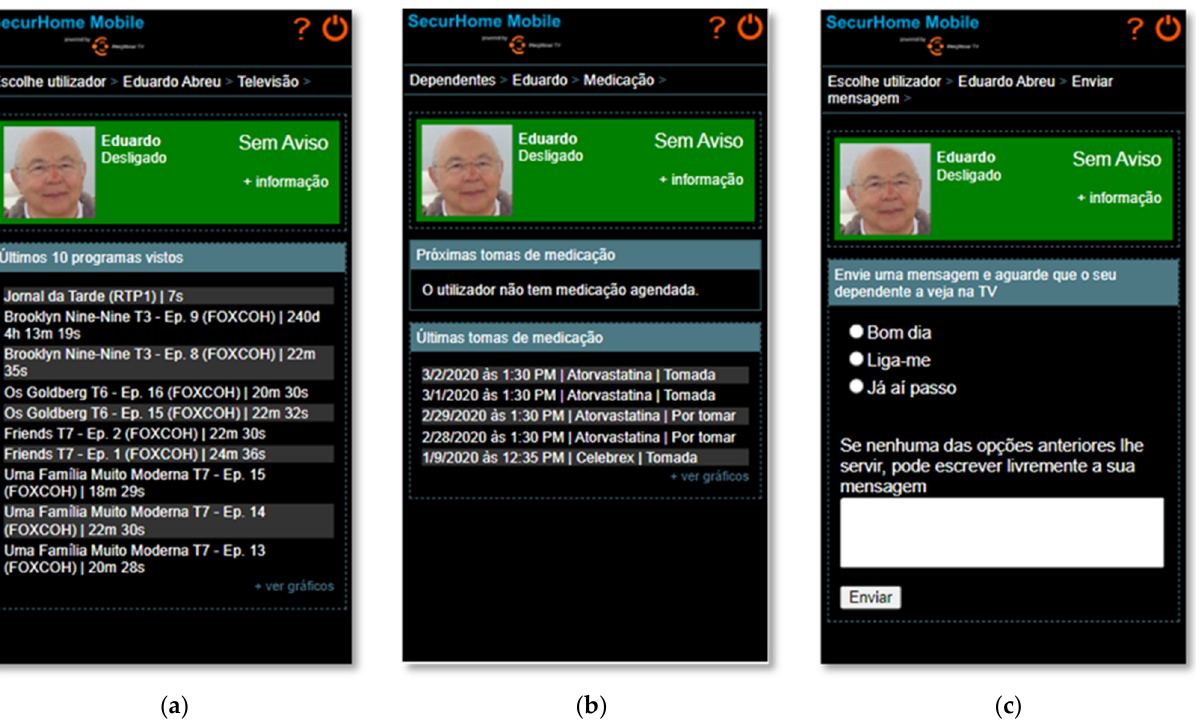
Figure 13. ( a ) Television consumption of a dependent viewed in the SecurHome Mobile application. ( b ) The medication schedule of a dependent in SecurHome Mobile. ( c ) The message sending area of SecurHome Mobile.